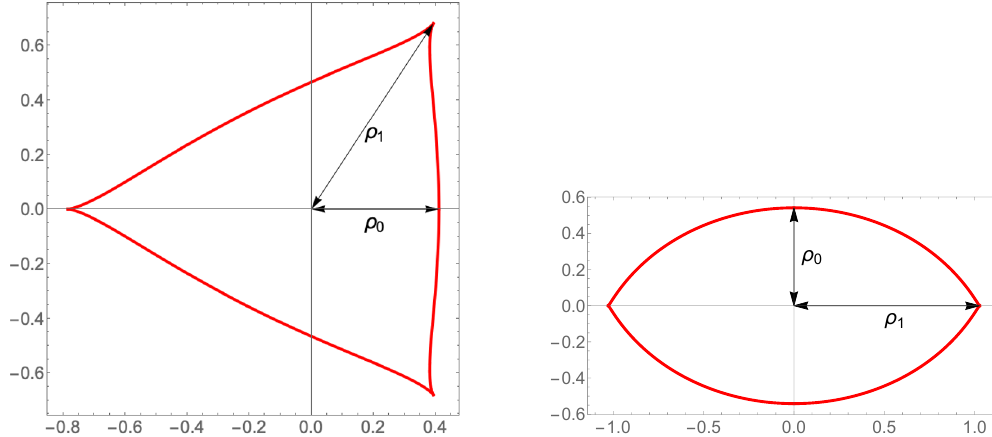
Figure 7 . Typical shapes of outward spike solutions. The left panel shows the solution with three outward spikes and one winding for ρ two outward spikes and one winding for ρ specific to de Sitter space.